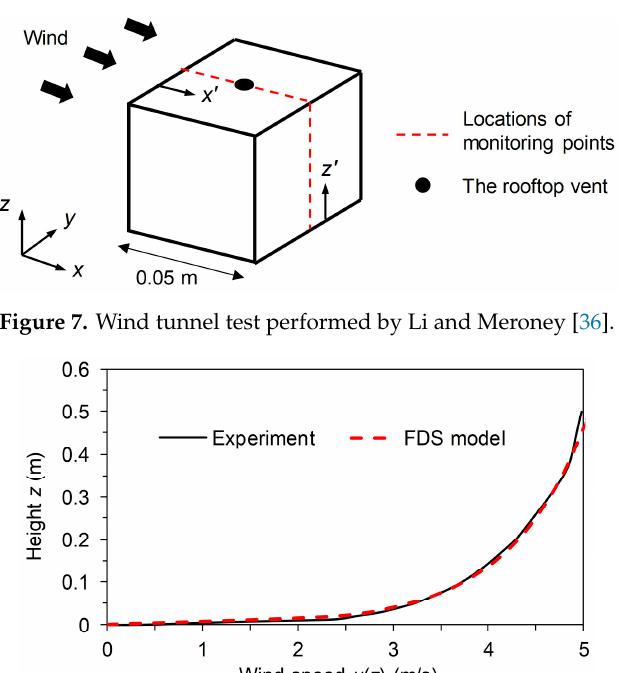
Figure 7. Wind tunnel test performed by Li and Meroney [36].